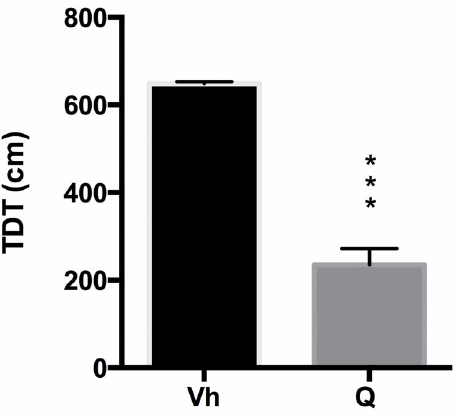
Figure 7. Ropinirole and OF. Effect of ropinirole on the total distance travelled (TDT) in the open field